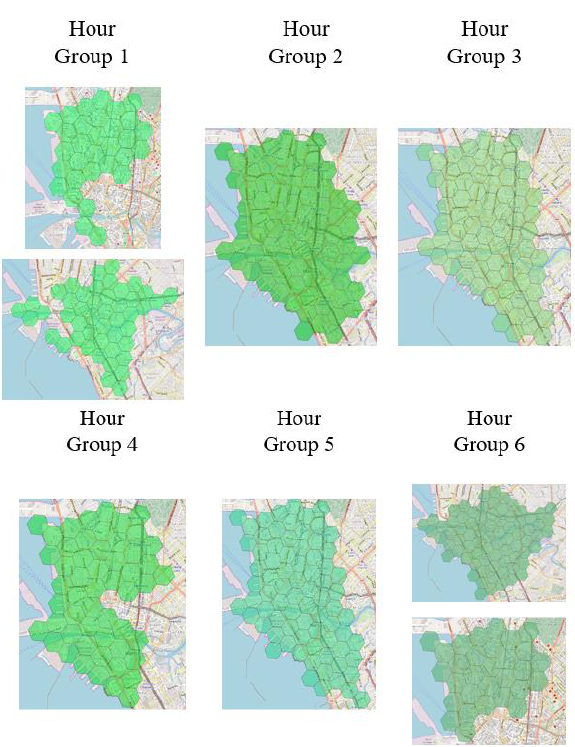
Figure 11. An example of evolving cluster across different hour